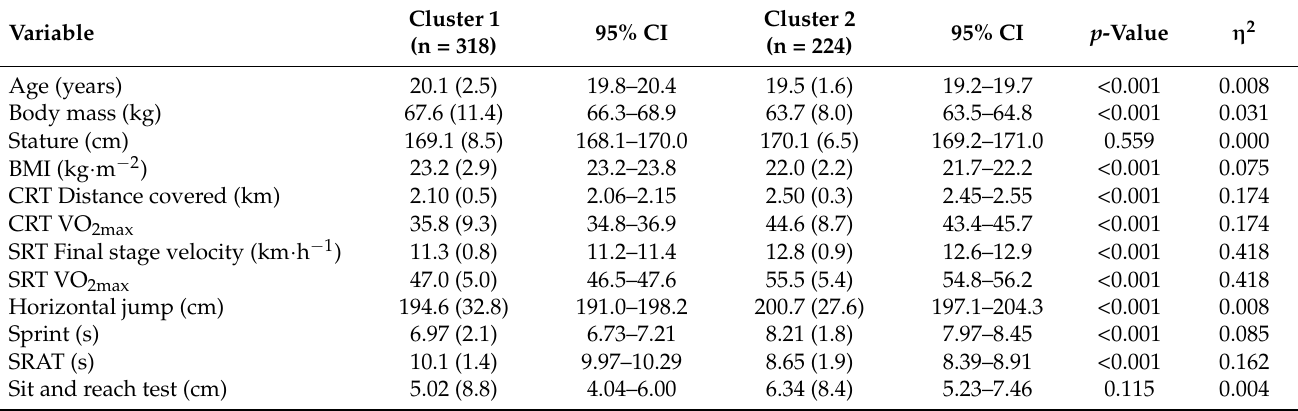
Table 3. Characteristics of the profiled phenotypes.